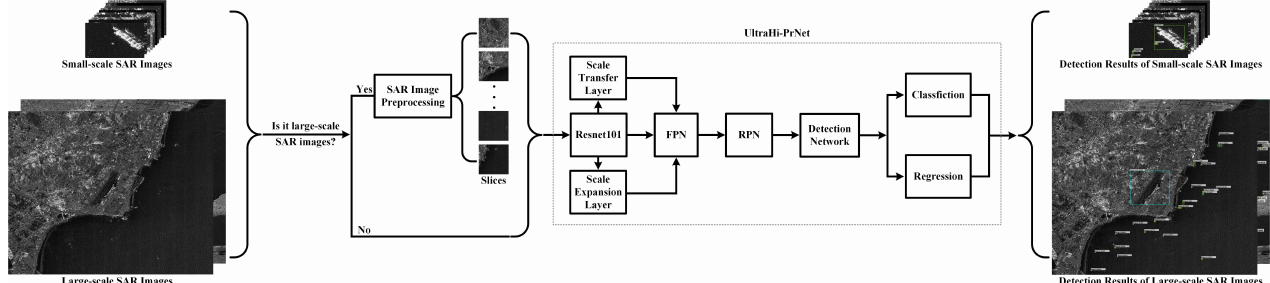
Figure 2. The entire flowchart of the algorithm. Firstly, the input SAR images of various sizes are preprocessed, then the preprocessed SAR images are transmitted to the proposed UltraHi-PrNet for feature extraction and detection, and finally, the SAR target detection results are